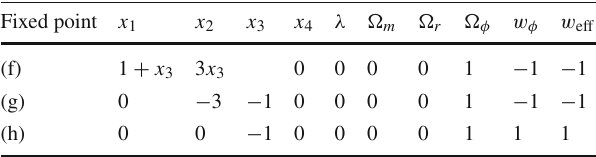
Table 2 The fixed points, the density parameters, and the equation of state parameters of the Cuscuta–Galileon with the inverse power-law potential for any integer n Fixed point x